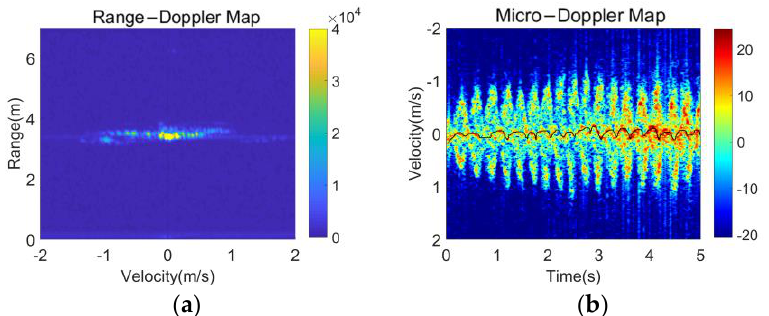
Figure 3. Different feature representation maps of human running: ( a ) RDM and ( b ) MDM.